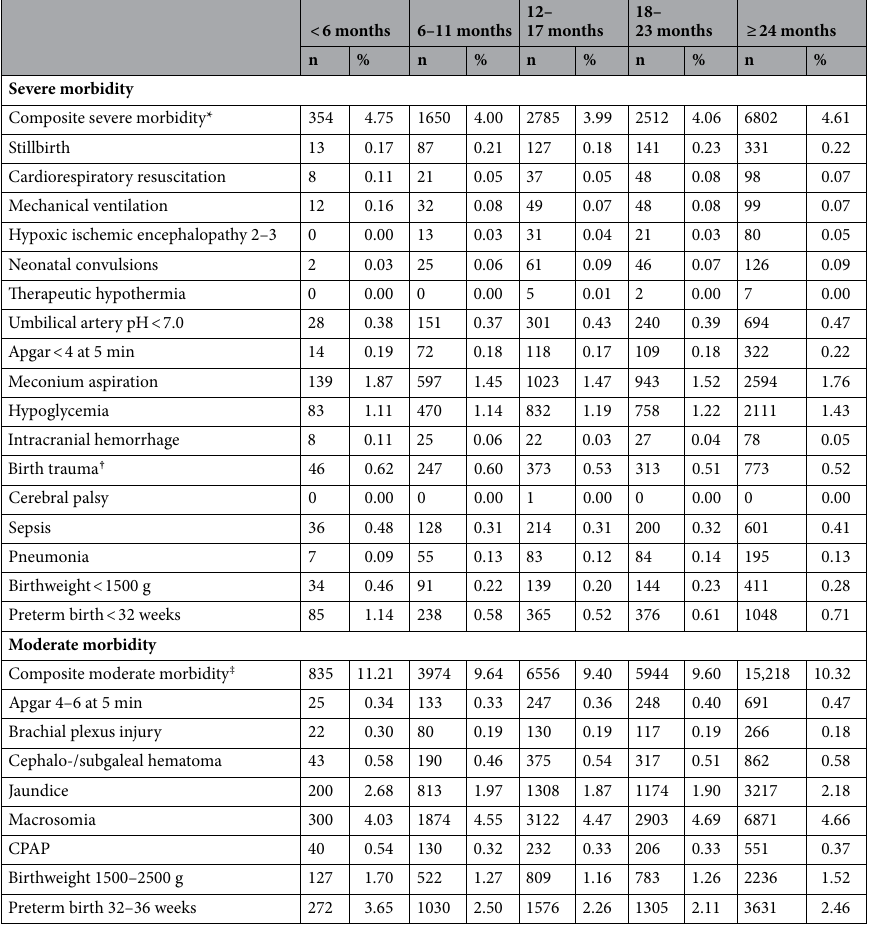
Table 3. Neonatal morbidity in the second birth across interpregnancy intervals. CPAP continuous positive airway pressure. *All components of severe morbidity presented below. † Fractures, neurologic injury, retinal hemorrhage, or facial nerve palsy. ‡ All components of moderate morbidity presented